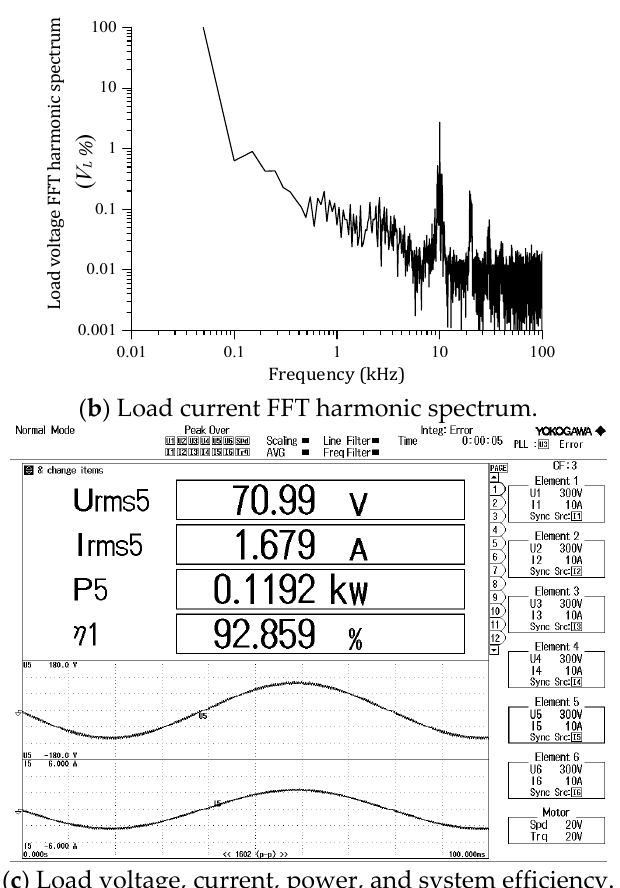
( c ) Load voltage, current, power, and system efficiency. Figure 17. Measurement of the 7-level inverter terminal-voltage at stand-alone load-voltage control.